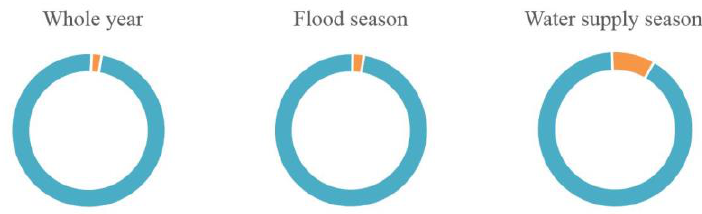
Figure 12. The interpretation degree of input factor on the reservoir outflow.